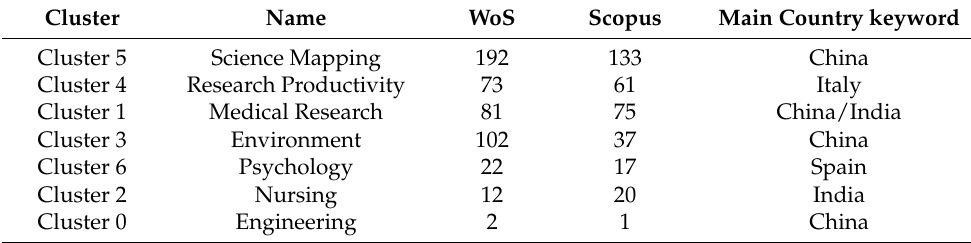
Table 18. Main database used for each cluster.